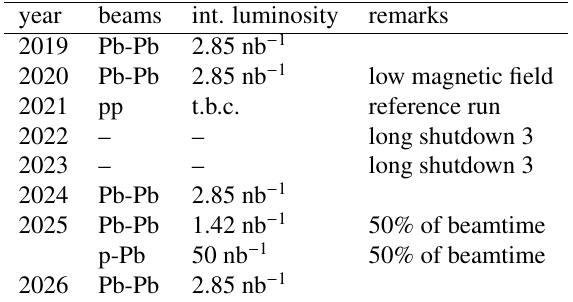
Table 2. Possible running scenario for the operation of the upgraded ALICE